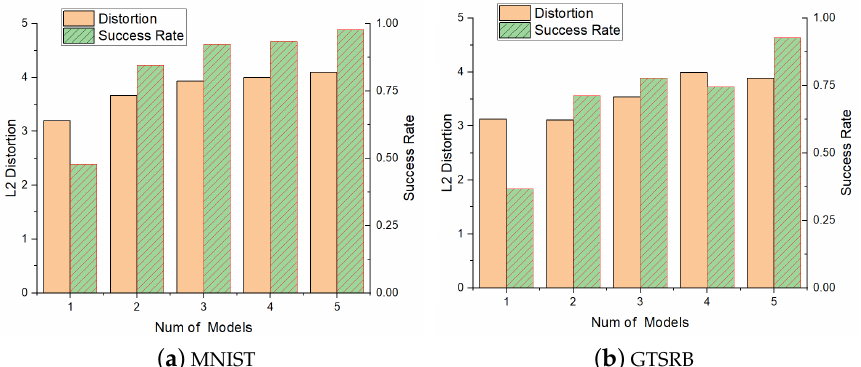
Figure 6. Influence of number of substitute models. The attacking success rate increases quickly when the number of substitute models increases.